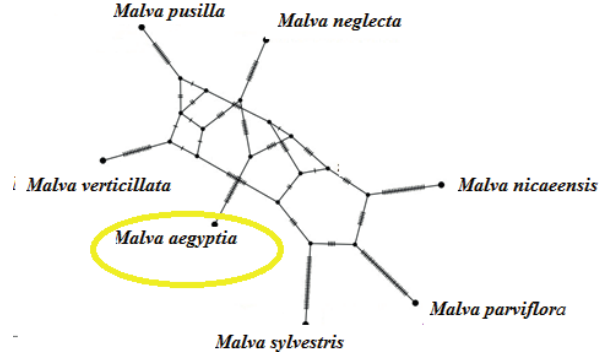
Figure 5. Integer NJ net tree produced while using RAPD data.